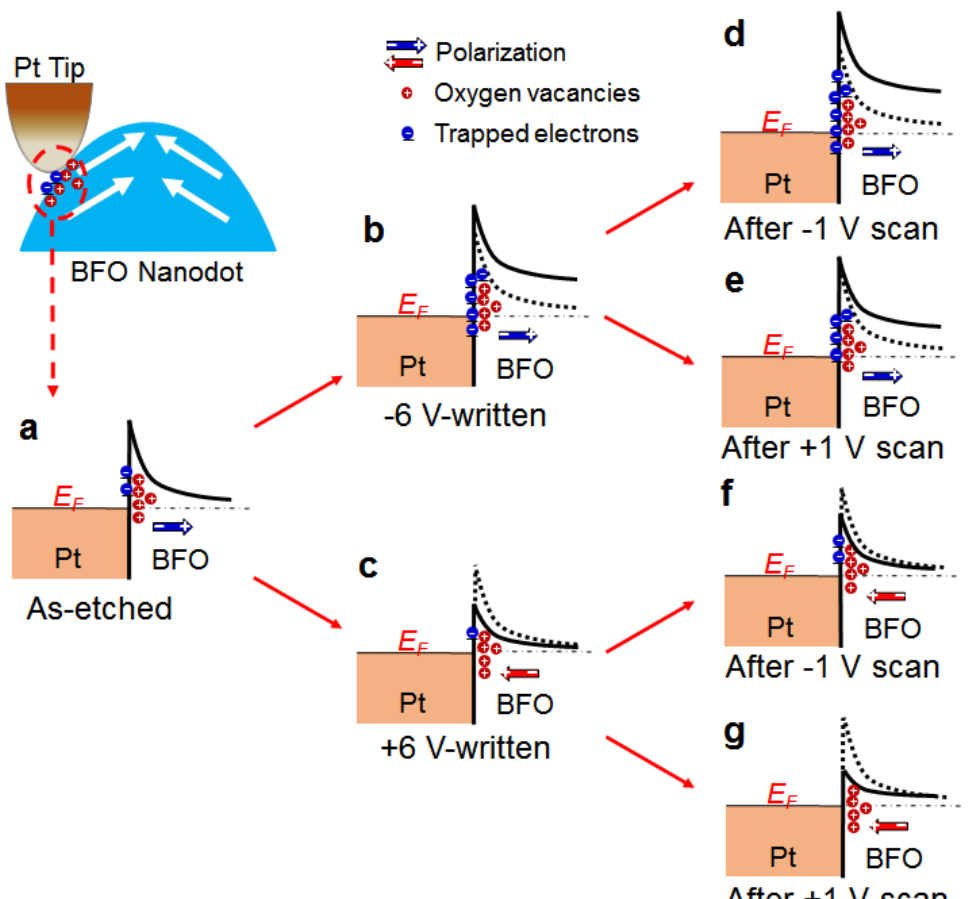
Figure 3. Schematic energy band diagrams in different states. Schematic energy band diagrams at the Pt tip/BFO interface of ( a ) as-etched, ( b ) − 6 V-written, and ( c ) +6 V-written states. Inset on the top of Panel a indicates the actual interface between the Pt tip and the BFO nanodot. The Schottky barrier in the − 6 V-written state further modified by the ( d ) − 1 V and ( e ) +1 V scans, and that in the +6 V-written state further modified by the ( f ) − 1 V and ( g ) +1 V scans.